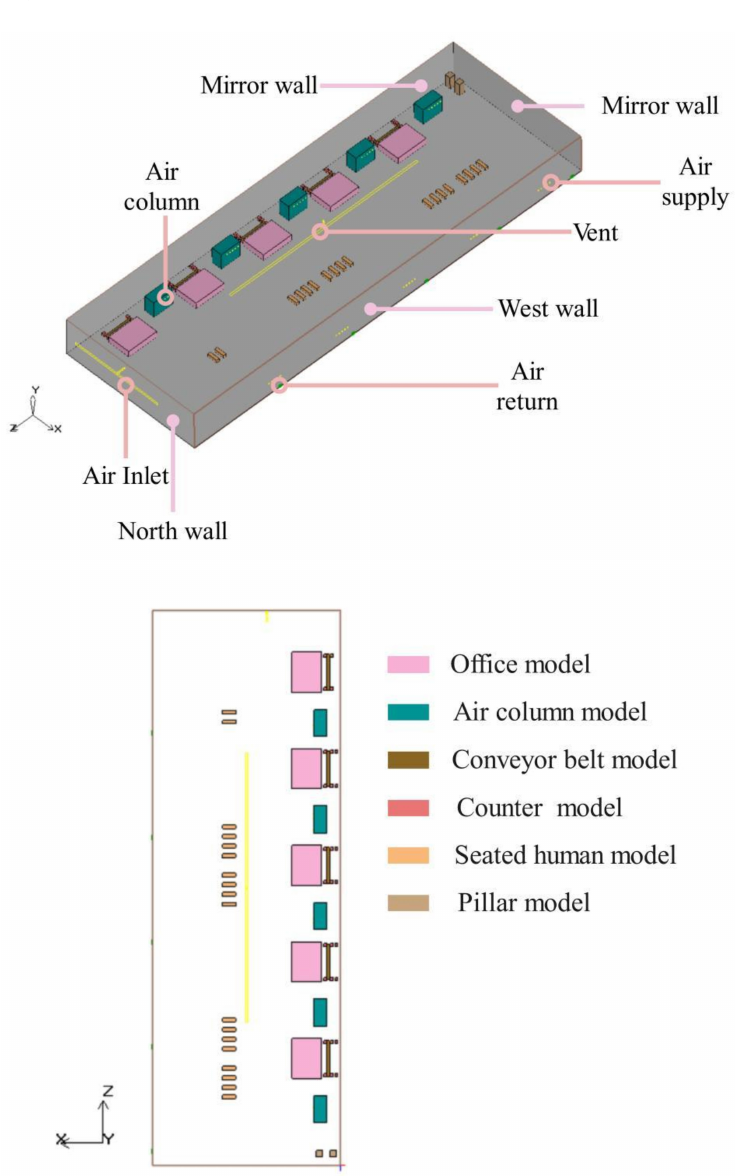
Figure 3. Three-dimensional model of the northwest 1/4 of the main building of the departure